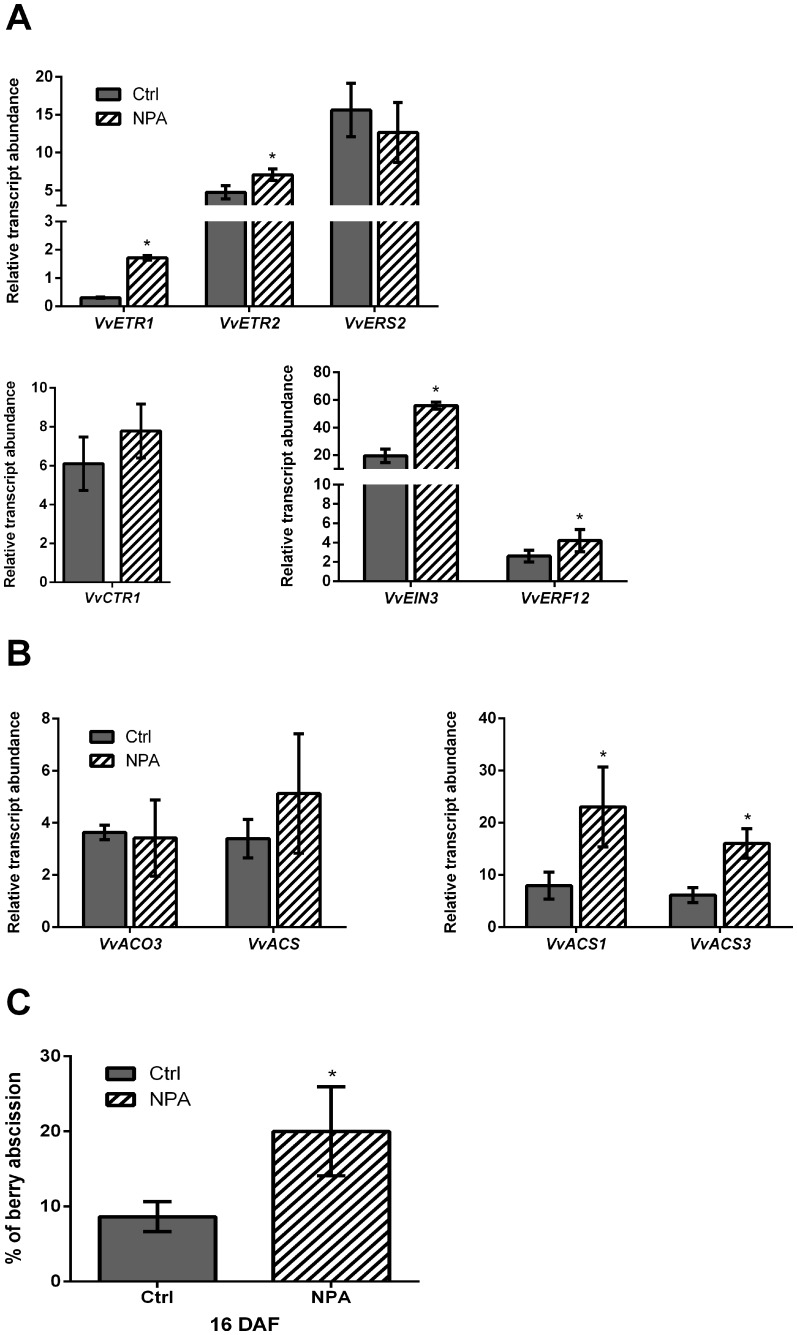
Transcript abundance of ethylene perception- and biosynthesis-related genes in “first berries” impaired in polar auxin transport.(A) Effect of blocking polar auxin transport at 14 DAF using 50 µM N-1-naphthylphthalamic acid (NPA) on transcript abundance of VvETR1, VvETR2, VvERS2, VvCTR1, VvEIN3, VvERF12 genes assessed 2 days post treatment (DPT), at 16 DAF. (B) Effect of blocking polar auxin transport at 14 DAF using 50 µM NPA on transcript abundance of VvACO3, VvACS, VvACS1 and VvACS3 genes assessed 2 DPT, at 16 DAF. Transcript abundance is relative to the mean expression of the constitutive genes VvUBI1 and VvGPDH (for more details, see Material and Methods section). (C) Effect of blocking polar auxin transport at 14 DAF on abscission using 50 µM NPA assessed 2 DPT, at 16 DAF. Treatment was done immediately after berry number per cluster was registered, and remaining berries were registered for percentage (%) of berry abscission estimation (for berry number see Table 2). Only “first berries” were analyzed. Asterisk indicates that differences are significant between NPA-treated and control berries. Significance was assessed using p value <0.05 (n = 3). Error bars are STERR±.